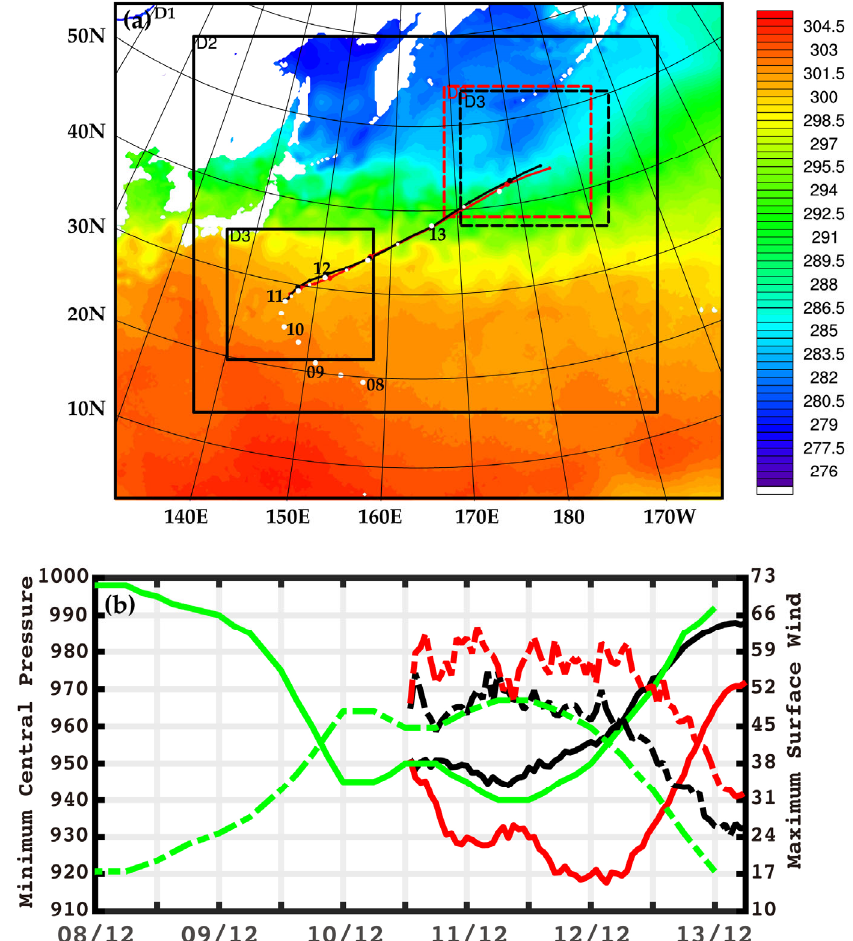
Figure 1. ( a ) WRF simulation domains overlaid with the SST (shaded; K ) in the control at the initial time (i.e., 0000 UTC 11 October) and cyclone tracks in simulations (black solid line for the control and red solid line for SST4.5; from 0000 UTC 11 October to 1800 UTC 13 October) and best track data (white dot; from the China Meteorological Administration (CMA); from 0000 UTC 08 October to 1200 UTC 13 October). The adjacent larger dots are 12 h intervals. D3 is the storm-following